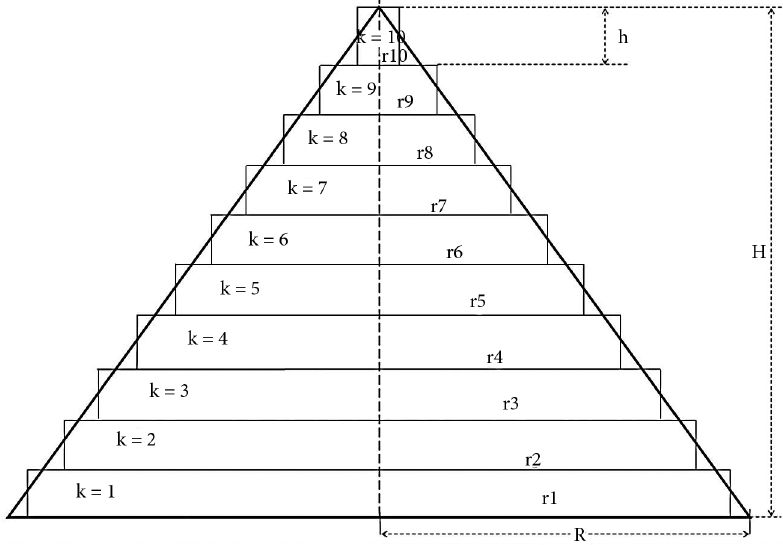
Figure 5. Vertical section of the